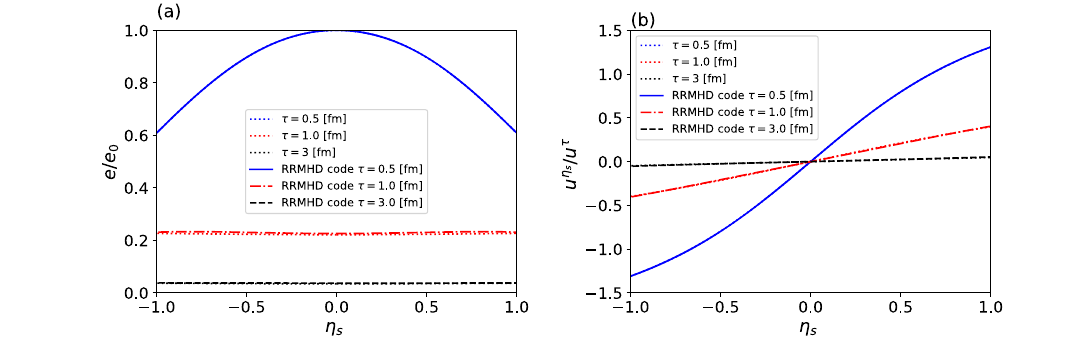
Fig. 16 We display a the ratio of the energy density of the fluid to the initial energy density and b the fluid velocity component u η s / u τ , respectively. The blue solid, red long dashed-dotted and black dashed lines show the numerical results at t = 0 . 5 , 1 . 0, and 3 fm, respectively.